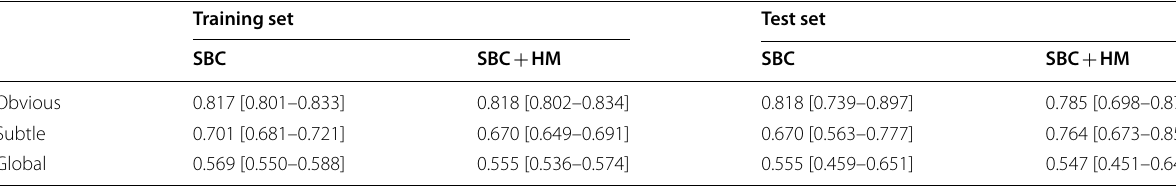
Table 6 AUCs for the probability of benign abnormality for the SBC and SBC versus the group of normal mammograms. This is calculated for the training set and the test set